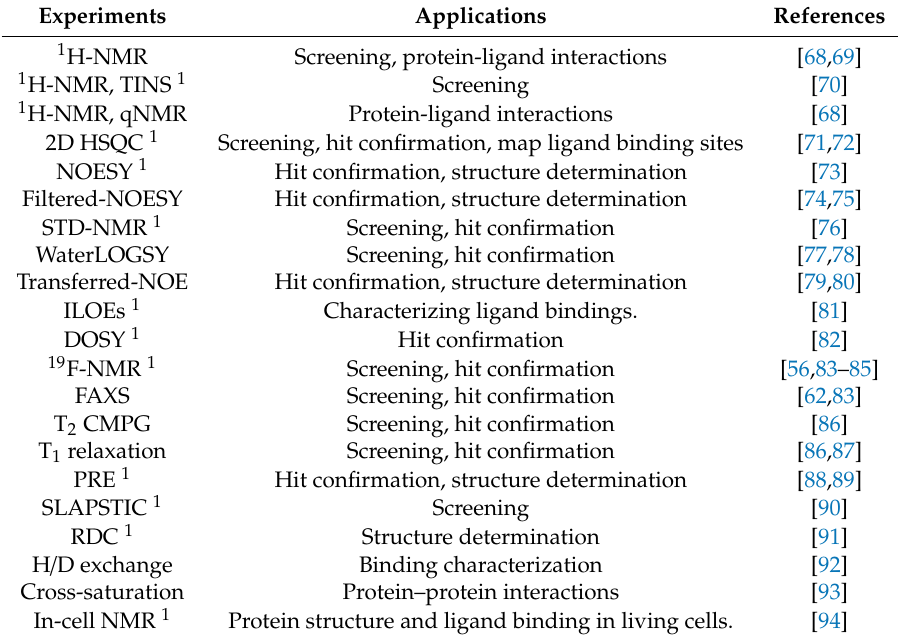
Table 1. Some NMR experiments used to probe protein-ligand